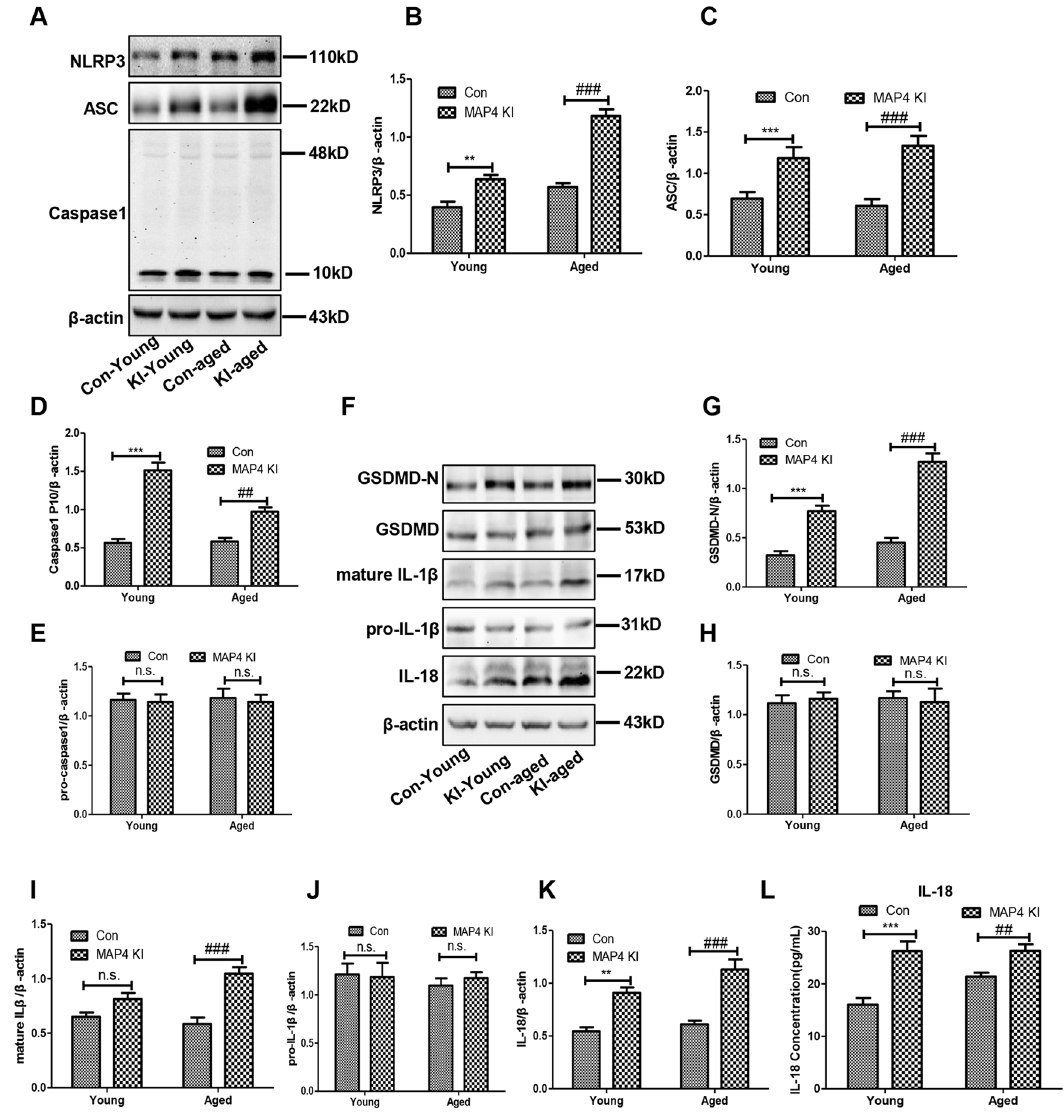
Fig. 3 Activated NLRP3-related pyroptosis in the myocardium of MAP4 KI mice. A Representative immunoblotting bands of NLRP3, ASC, caspase-1 (p10), and pro-caspase-1 in the myocardium; n = 5. B – E The statistical analysis of NLRP3, ASC, and Caspase-1. ** p < 0.01 and *** p < 0.001 versus the Con-young group. ## p < 0.01 and ### p < 0.001 versus the Con-aged group. N.S. represents no statistical difference; n = 5. F Representative immunoblotting bands of GSDMD-N, GSDMD, pro-IL-1 β , mature IL-1 β , and IL-18 in the myocardium; n = 5. G – K The statistical analysis of GSDMD-N, GSDMD, pro-IL-1 β , mature IL-1 β , and IL-18. ** p < 0.01 and *** p < 0.001 versus the Con-young group. ### p < 0.001 versus the Con-aged group. N.S. represents no statistical difference; n = 5. L A scatter diagram showing the concentration of IL-18 in the plasma. *** p < 0.001 versus the Con-young group. ## p < 0.001 versus the Con-aged group; n = shown to successfully induce the intracellular phosphorylation of Inhibited angiogenesis and activated NLRP3 in fl ammasome MAP4 (Fig. 4D, p < 0.05), whereas the MAP4 (Ala) adenovirus were induced by p-MAP4 in vitro showed no effects on p-MAP4. These results indicated that the Furthermore, to evaluate the effect of p-MAP4 on the NLRP3 MAP4 (Glu) adenovirus effectively mimicked the intracellular in fl ammasome in endothelial cells, we used MAP4 (Glu) and MAP4 phosphorylation of MAP4 in vitro. (Ala) adenoviruses to simulate the phosphorylation or depho- Next, we conducted a tube formation assay as a direct way to sphorylation of MAP4 in vitro, respectively. Considering that the determine the in fl uence of p-MAP4 on angiogenesis. As shown in corresponding CMV-null of the two adenoviruses has been Fig. 4E, the angiogenic abilities of endothelial cells were consistently shown no effects on the phosphorylation or depho- signi fi cantly inhibited by p-MAP4. Moreover, the capillary length sphorylation of MAP4, we included it for veri fi cation in the current of the tube in the Ad-MAP4 (Glu) group was signi fi cantly shorter study [1, 5, 6, 11, 22]. In addition, we con fi rmed the roles of MAP4 than that of the CMV-null and Ad-MAP4 (Ala) groups (Fig. 4F, p < (Glu) and MAP4 (Ala) on the phosphorylation of MAP4. As shown 0.01). These results indicated that p-MAP4 inhibited angiogenesis in Fig. 4A, following the incubation of cells with MAP4 (Glu) or in vitro. MAP4 (Ala) adenoviruses for 48 h, the levels of HA-MAP4 and Next, we analyzed the NLRP3 in fl ammasome in MAP4 (Glu) MAP4 were signi fi cantly elevated compared with the CMV-null- adenovirus-treated HUVECs. As shown in Fig. 4G, compared with treated group (Fig. 4B and C, p < 0.05). Meanwhile, MAP4 (Glu) was